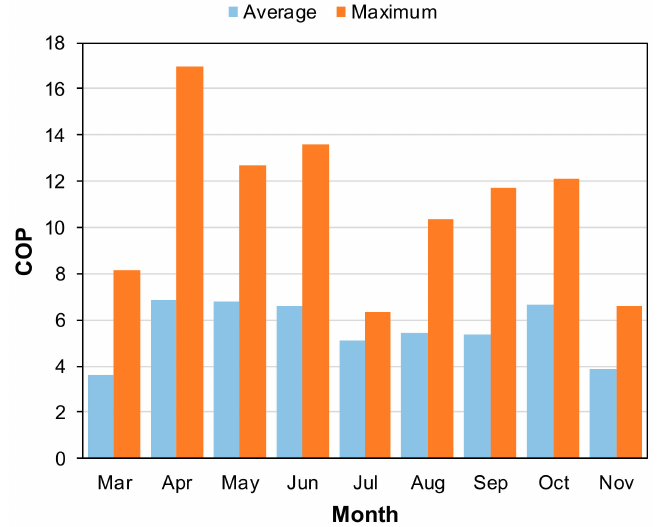
Figure 12. Predicted average and maximum COP of the EAHE during March to